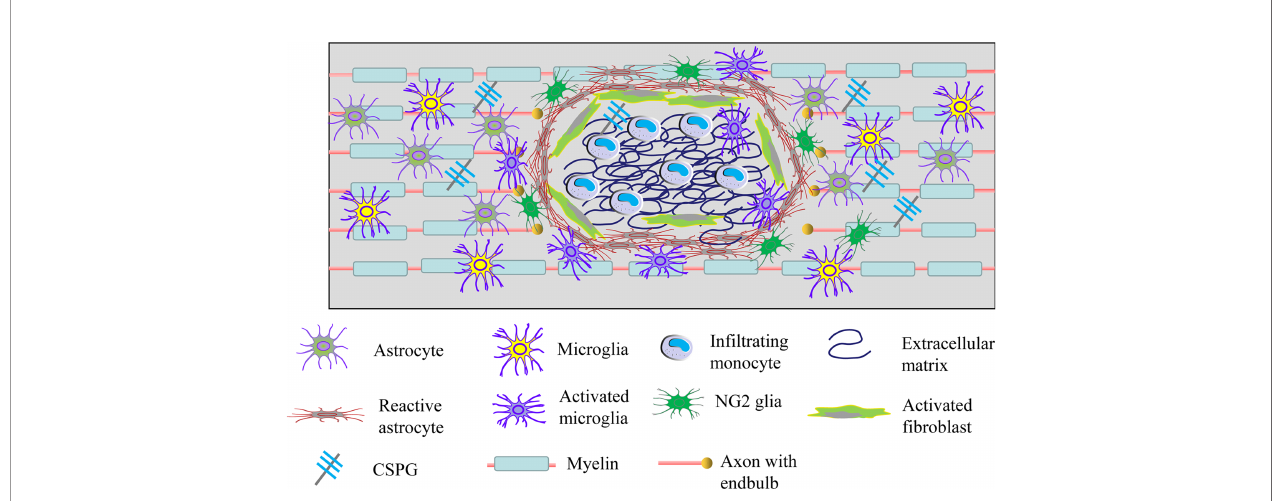
FIGURE 3 | Cellular and extracellular components of glial scar after SCI. Resident astrocytes, microglia and NG2 glia become migratory, proliferate, activated and lead to the glial scar after injury. Meanwhile, fi broblasts and circulating immune cells in fi ltrate into the damaged tissue and then increase the deposition of extracellular matrix molecules including extracellular matrix and CSGP. Glial scar can isolate the damaged spinal cord tissue, but it also limits the axonal